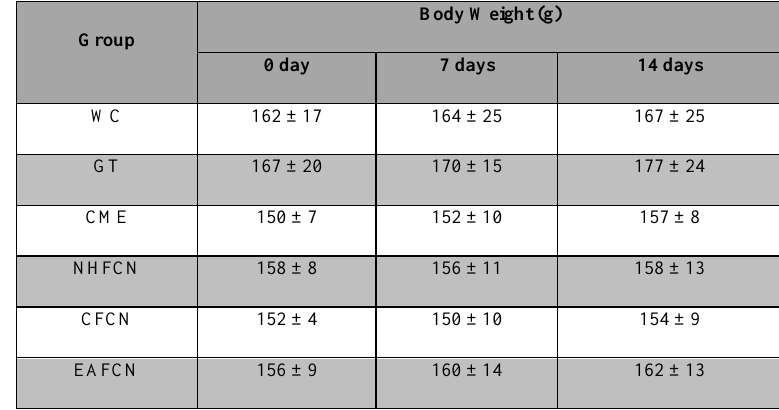
Table 3. Effects on body weights of Cocos Nucifera extracts on type II diabetic